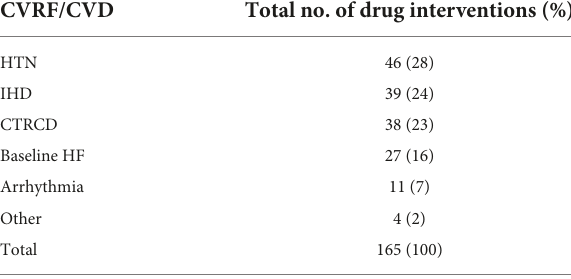
TABLE 5 Frequency of drug interventions by the heart team in different CVRF/CVD.